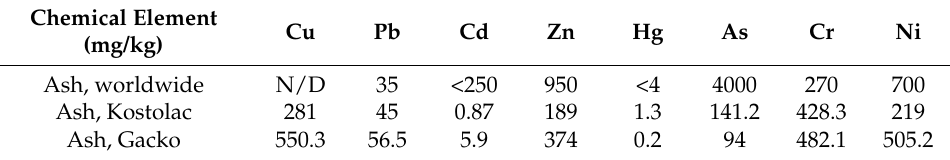
Table 1. Maximum values of investigated heavy metals in ash